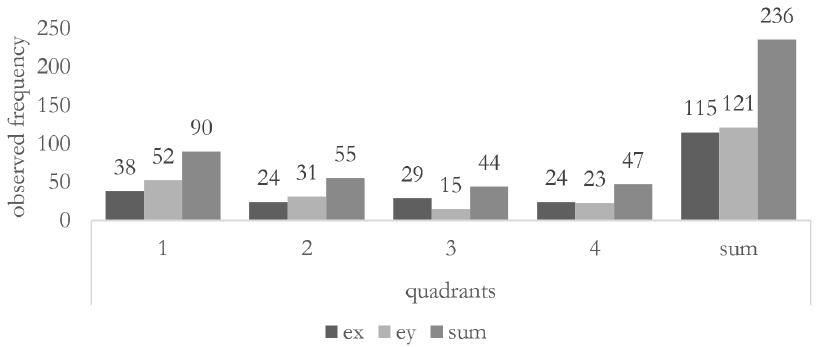
Figure 6 - Observed frequency of deformation ɛ x and ɛ y by quadrants.